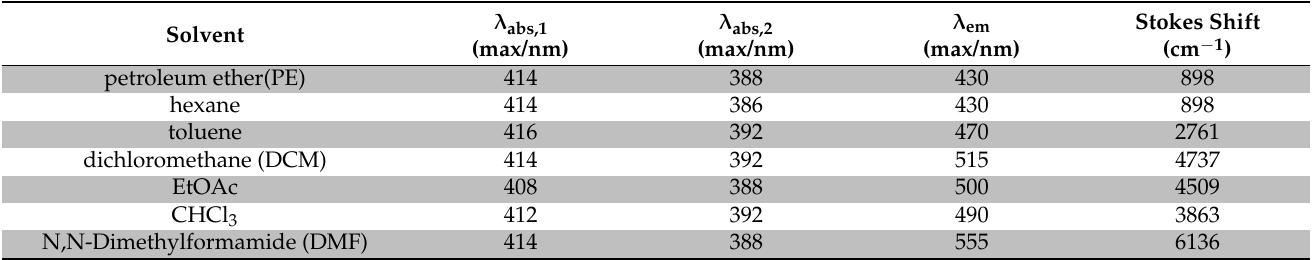
Figure 5 . Normalized photoluminescence spectra of PY-C16 in different solvents. Table 1. The positions of the highest peaks of PY-C16 absorption and emission spectra in different